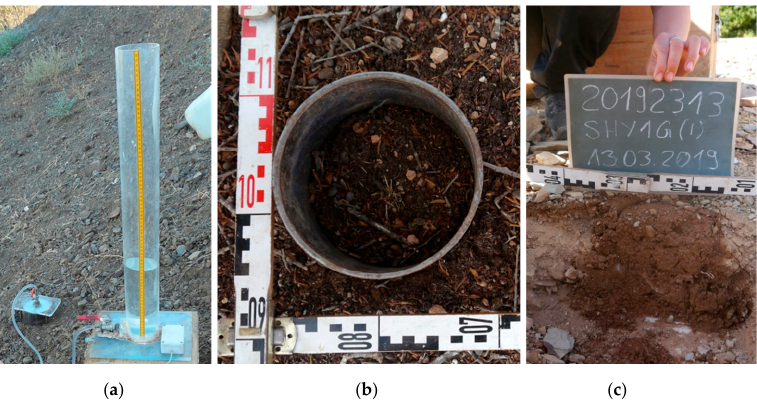
Figure 4. ( a ) Single-ring infiltrometer; ( b ) plot record before the experiment; ( c ) profile of the infiltration plot after experiment.